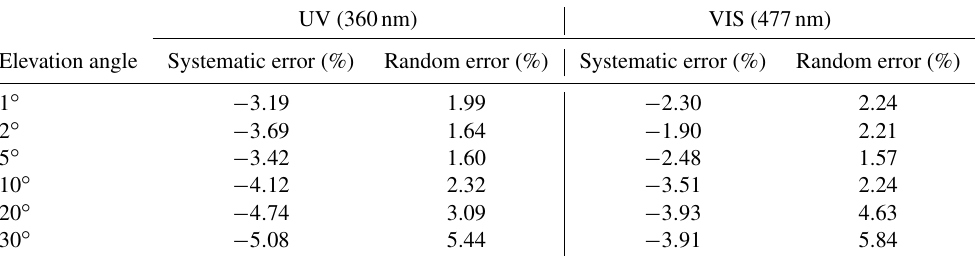
Table 3. Systematic and random errors caused by the topography simplification. Results are calculated from the relative differences of O 4 DSCDs simulated with a flat surface at 2650m compared to those simulated with the pseudo-reality surface in 18 cases (see text). The mean of the relative difference for each elevation angle and each wavelength is considered to be the systematic error. The standard deviation of the relative difference is considered to be the random